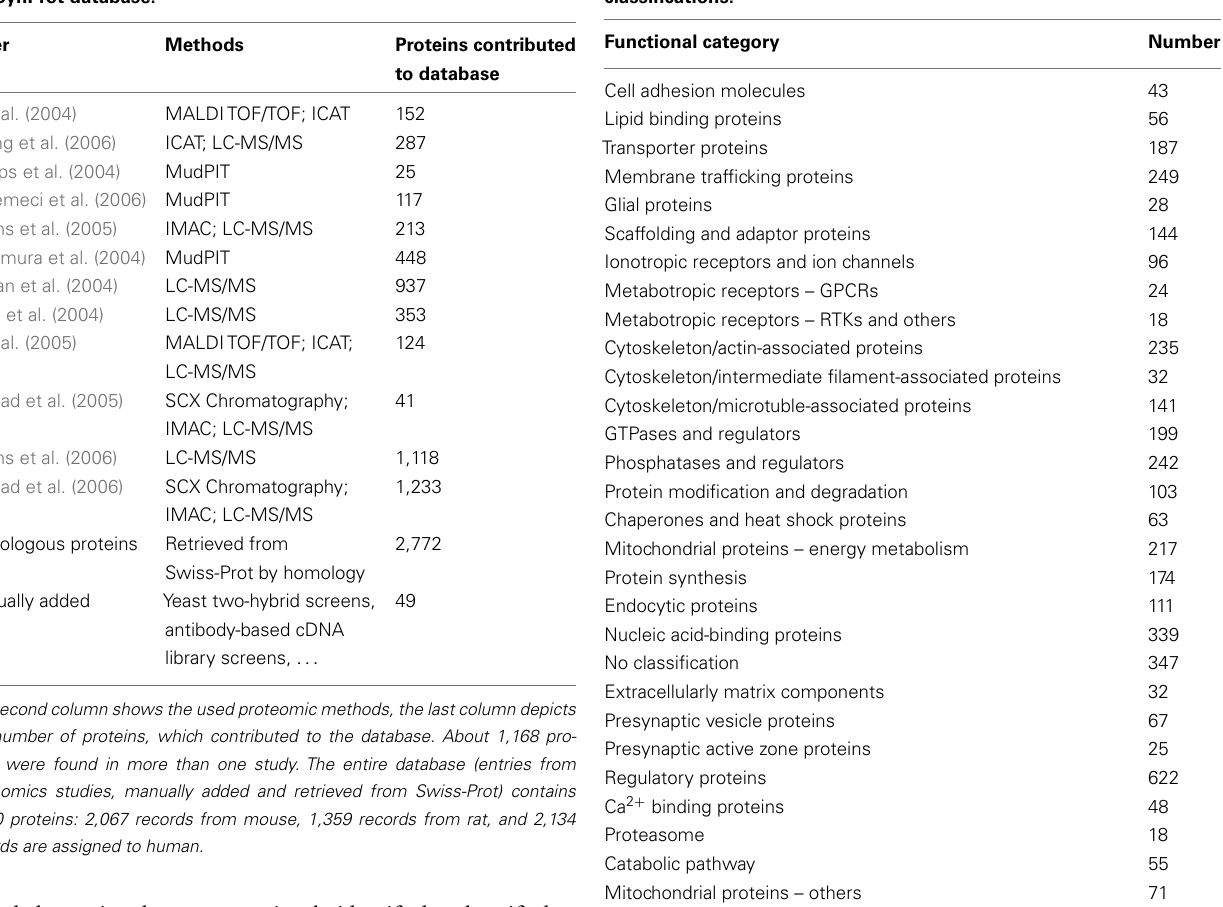
Table 2 | Contributions of the selected 12 proteomic publications to the SynProt database.